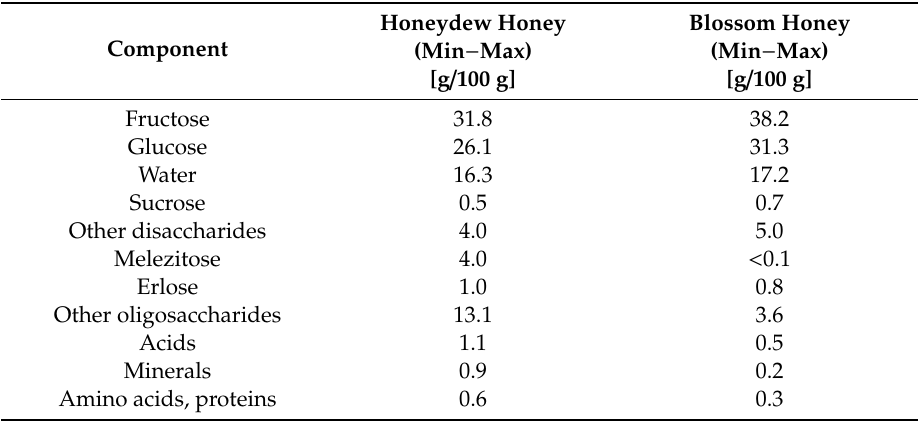
Table 1. Composition of honeydew and blossom honey